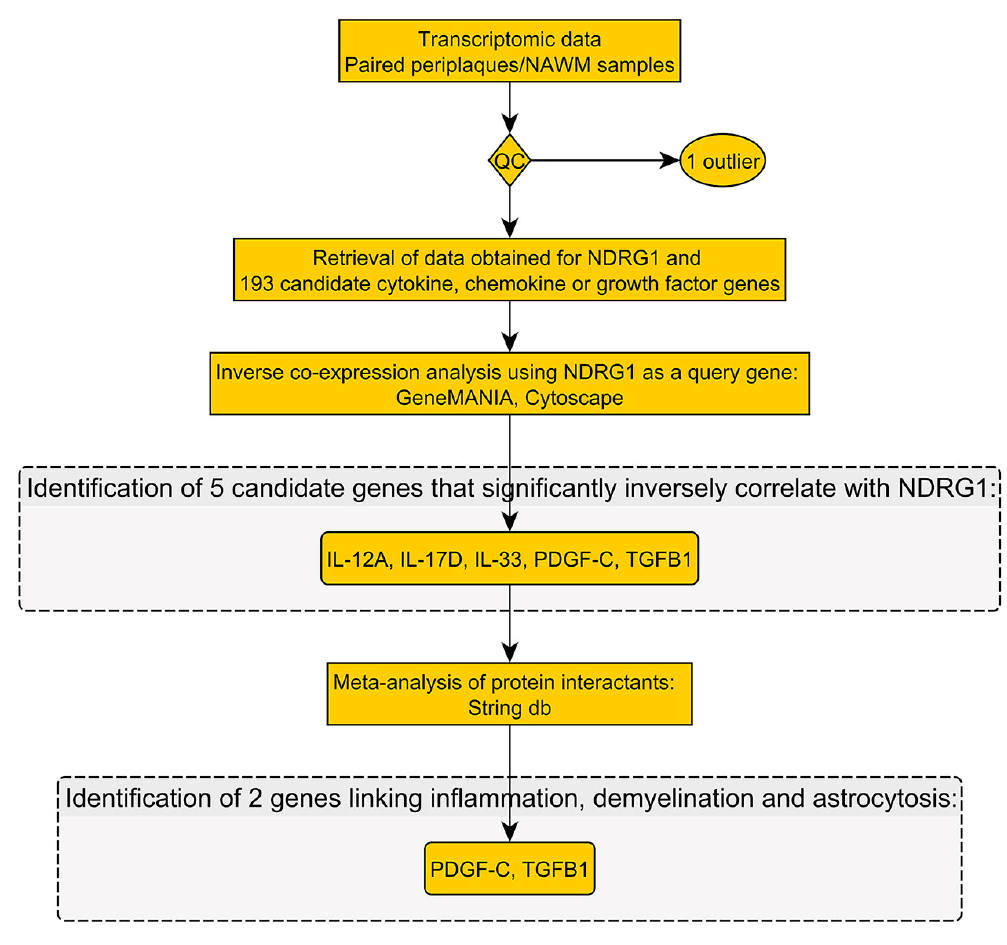
Figure 2. Workflow No. 2.